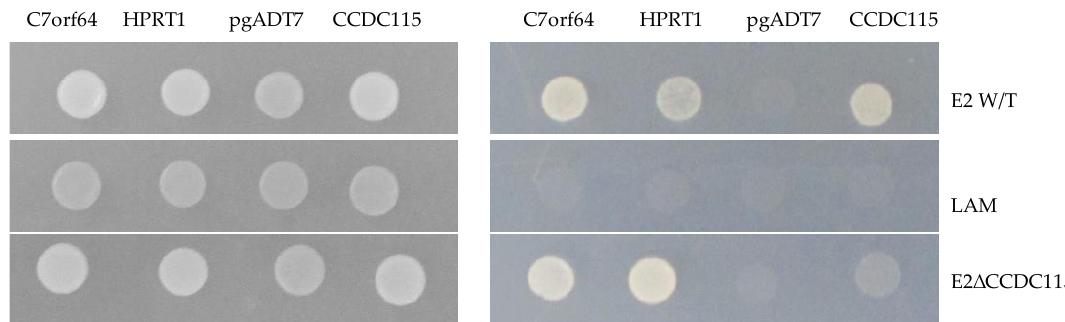
Figure 2. Yeast two-hybrid reactivity of E2 and E2 ∆ CCDC115. The indicated plasmids were transformed into the yeast strain AH109 and spotted on the left on -Trp / -Leu plates for plasmid selection and on the right on selective media -Trp / -Leu / -Ade / -His. C7orf64, HPRT1 and CDC115 are expressed with the activation domain for the yeast two-hybrid in the pgADT7 vector. pgADT7 is used as a negative control. E2 W / T, Lam and E2 ∆ CDC115 are expressed with the binding domain for the yeast two-hybrid. Lam is used as a negative control.